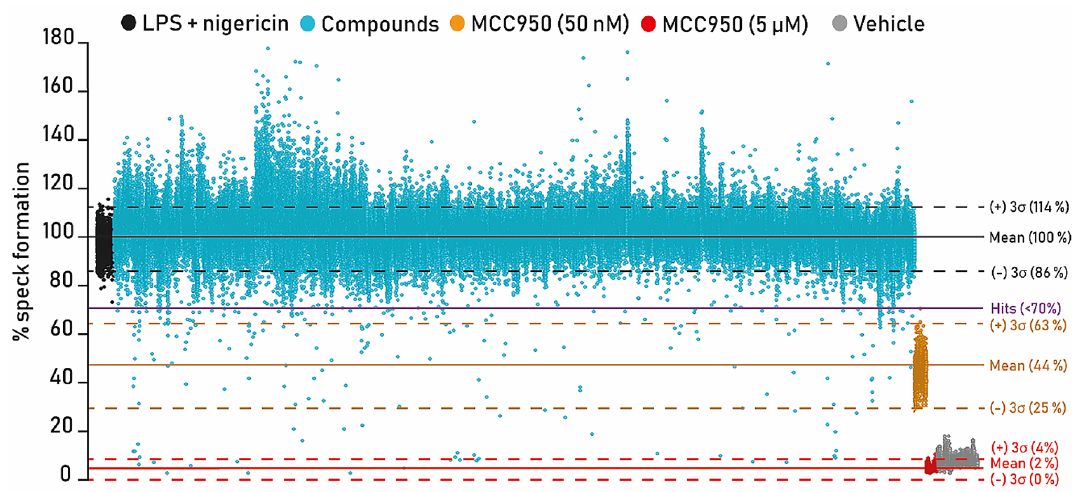
Figure 3. High-throughput screening, identification of hit compounds. ASC-mCherry iBMDM cells were treated with 5 µM of each of the 81,000 compounds (represented by each blue dot) and LPS (1 µg/ml) for 2 h followed by nigericin treatment (10 µM, 2 h) after which PFA was added. The percentage (%) speck formation of ASC specks/total nuclei normalised to LPS + nigericin are presented; LPS + nigericin treated wells are indicated in black on the left-hand side. MCC950 50 nM treated wells are indicated in orange (right hand side), while MCC950 5 µM treated wells are in red (on the right hand side), representing complete speck inhibition. Vehicle treated cells are on the right in grey. Data was analyzed using TIBCO Spotfire version 11 software (https:// www. tibco. com/ produ cts/ tibco- spotfi